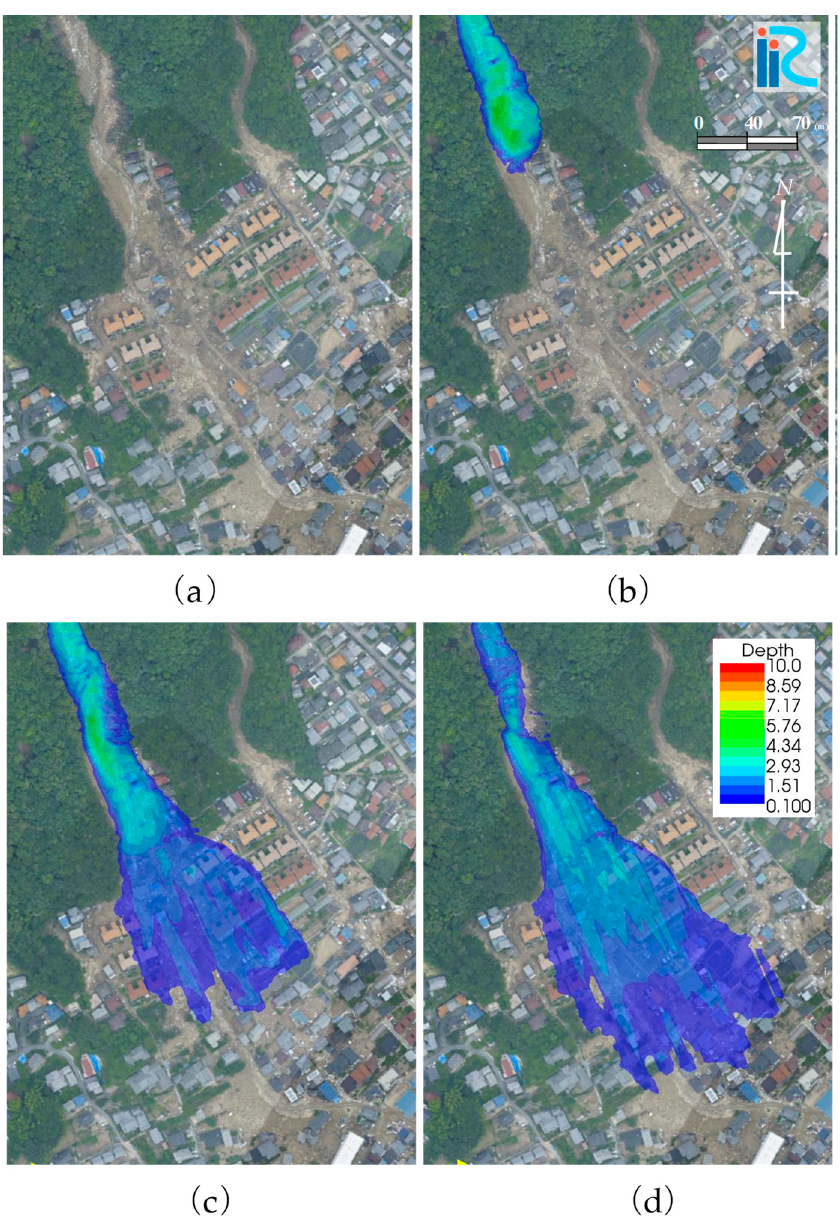
Figure 17. Case 2: Spatiotemporal change in debris flow depth in the residential area. Houses and buildings were not considered in this analysis. ( a ), ( b ), ( c ), and ( d ) show the flow depth at 5 s, 43 s, 105 s, and 200 s, respectively.